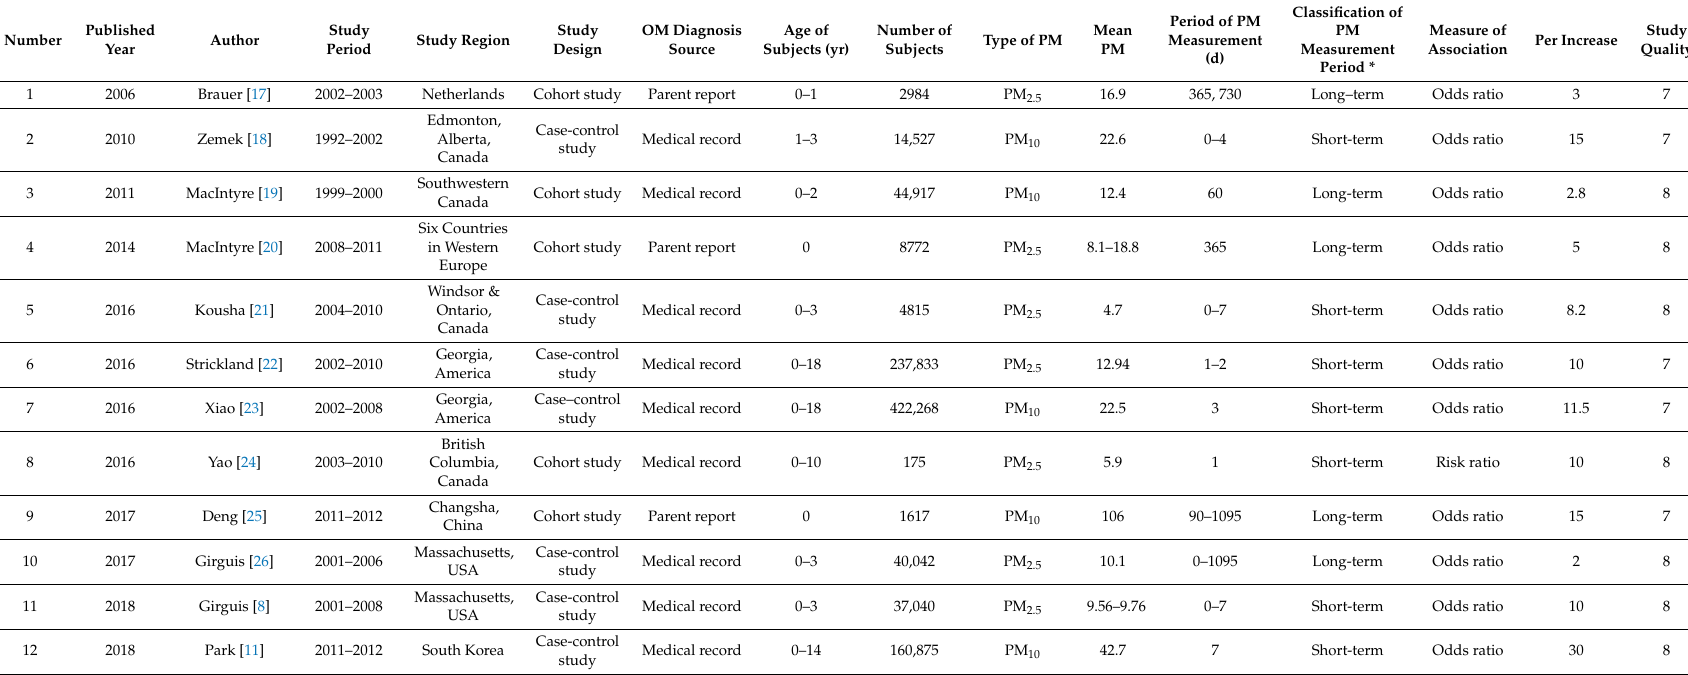
Table 1. Characteristics of included